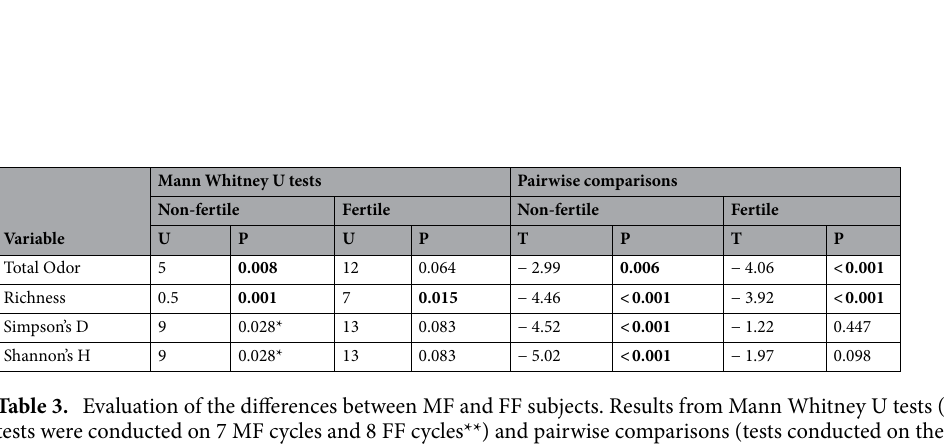
Figure 7. Comparison of the matched pairs of fertile and non-fertile samples for the 15 cycles, using Total Odour, Richness, Shannon’s H, Simpson’s D, and MDS1 and MDS2. Each line represents a cycle and the colours represent the different females. Only Total Odour shows a clear difference between non-fertile and fertile samples. Greater clustering of lines by individual (colour) indicates lower variability in the odour profile of each female.